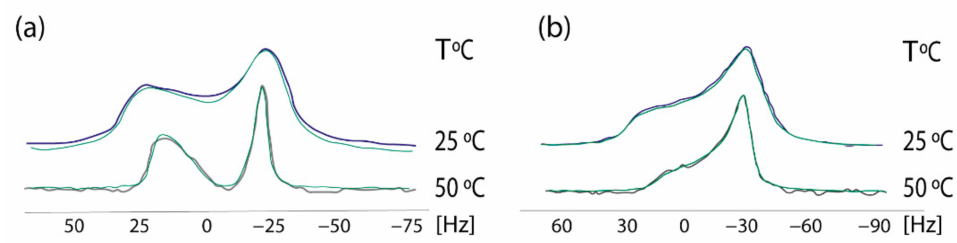
Figure 5. Experimental (black and purple lines) and simulated (green lines) of 31P NMR Scheme 0. ( a ) DPPC alome ( b ) DPPC with candesartan cilexetil at the temperatures of 25 and 50 ◦ C. Solid state 31 P CP NMR. Spectra were obtained on a Bruker MSL-400 NMR spectrometer (Rheinstetten,